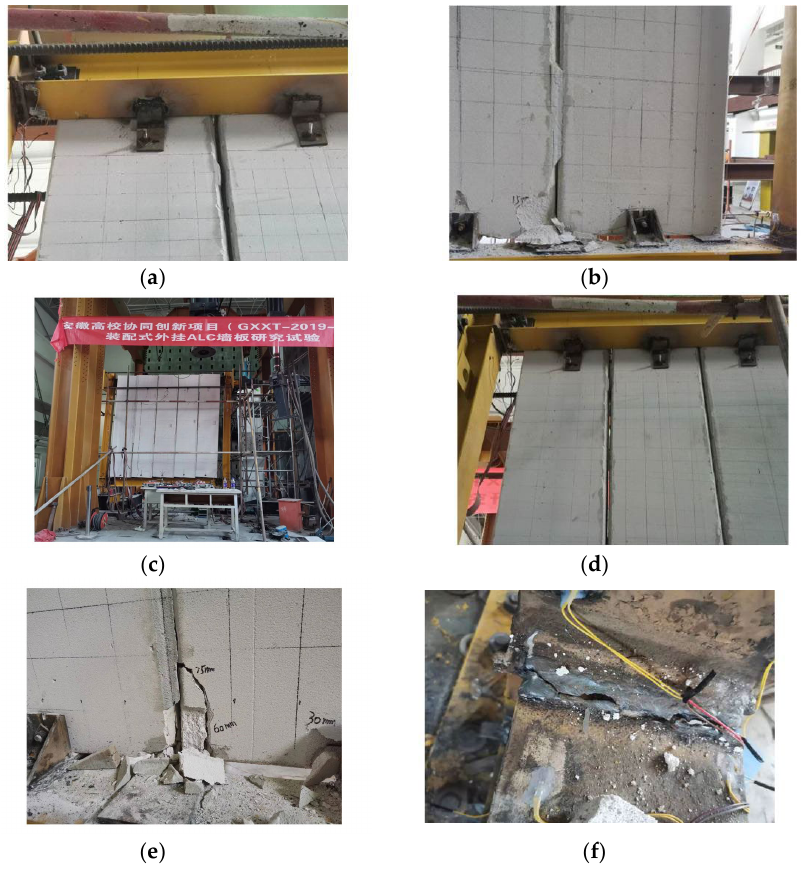
Figure 11. Test phenomenon of DN. ( a ) Adhesive mortar cracking. ( b ) Adhesive mortar falling off. ( c ) Obvious dislocation between panels. ( d ) Connecting bolt slipped. ( e ) Crushed concrete at the corner of wall panels. ( f ) The weld seam cracked at beam-column welding.